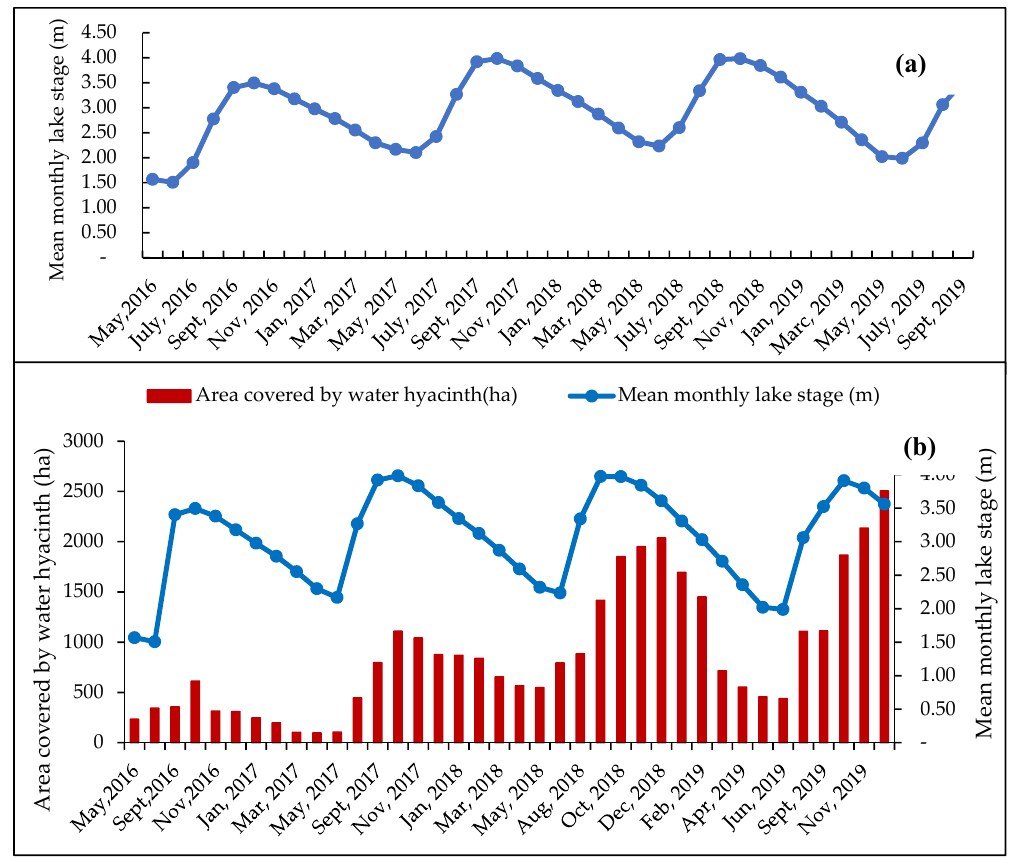
Figure 5. Graphical presentation of the mean monthly lake stage ( a ) and the correlation between area covered by water hyacinth and mean monthly lake stage ( b ) from 2016 -2019.